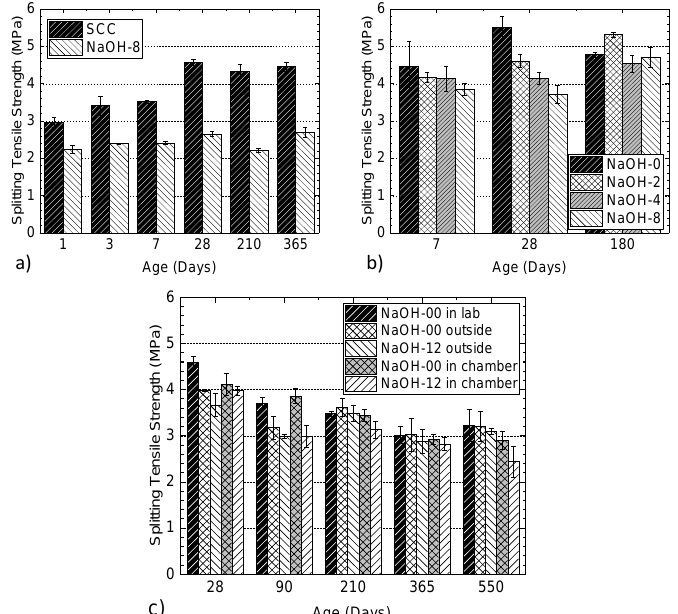
Figure 19. Influence of alkali addition on splitting tensile strength at different ages: ( a ) NaOH-8 and SCC mixtures from the larger batch series, ( b ) NaOH mixtures from the smaller batch series and ( c ) NaOH-00 and NaOH-12 mixtures.